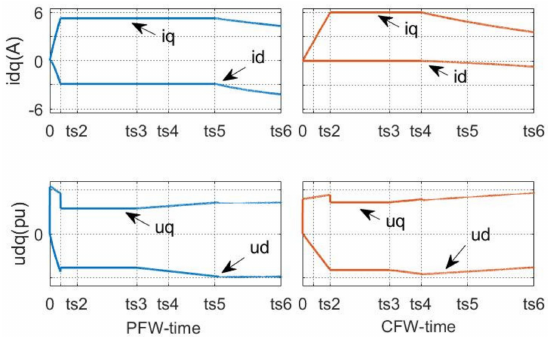
Figure 9. Current and dq-voltage. From left to right: PFW-MPC and CFW-MPC.